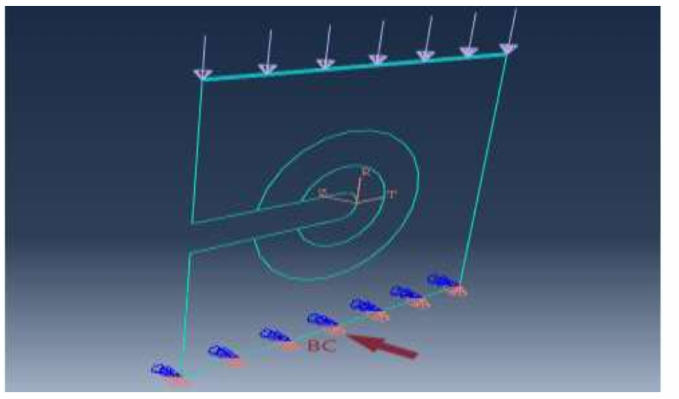
Figure 3. Loading and boundary conditions for the U-notched specimen subjected to compres- sive